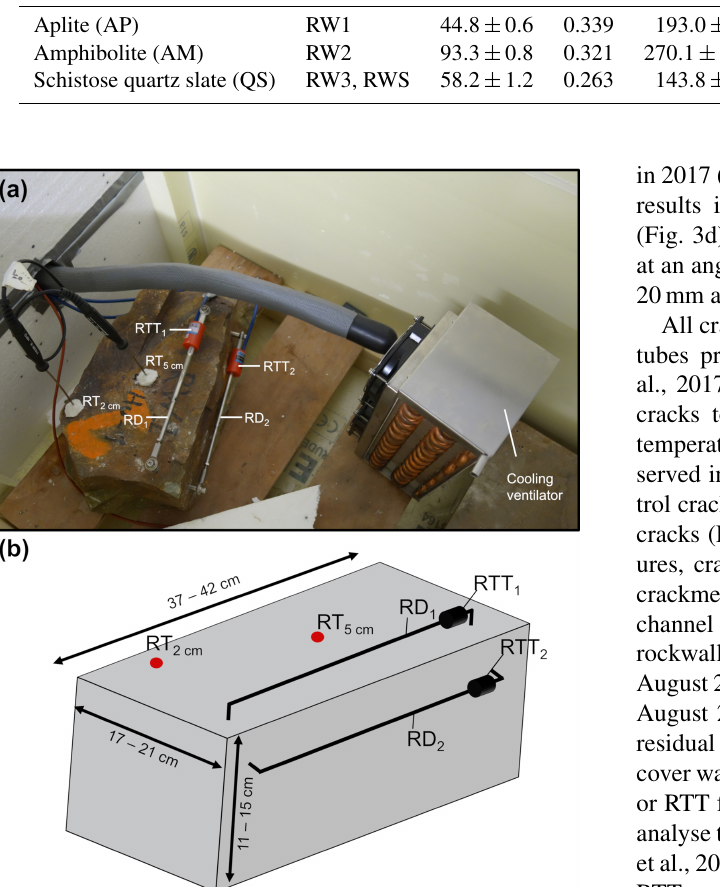
Figure 2. (a) Cooling chamber with aplite sample from RW1. (b) Schematic illustration of the sensors at the rock samples. Rock deformation (RD) was measured by two crackmeters. Thermistors record rock-top temperature (RTT) for temperature correction of RD. Two temperature sensors measured rock temperature at 2cm (RT 2cm ) and 5cm (RT 5cm )